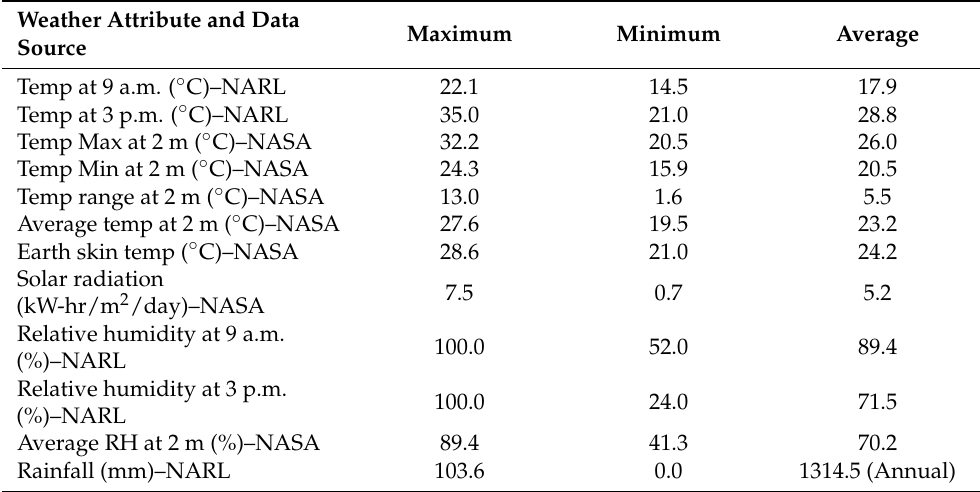
Table 1. Daily weather attributes between January 2016 and January 2019 at the National Agricultural Research